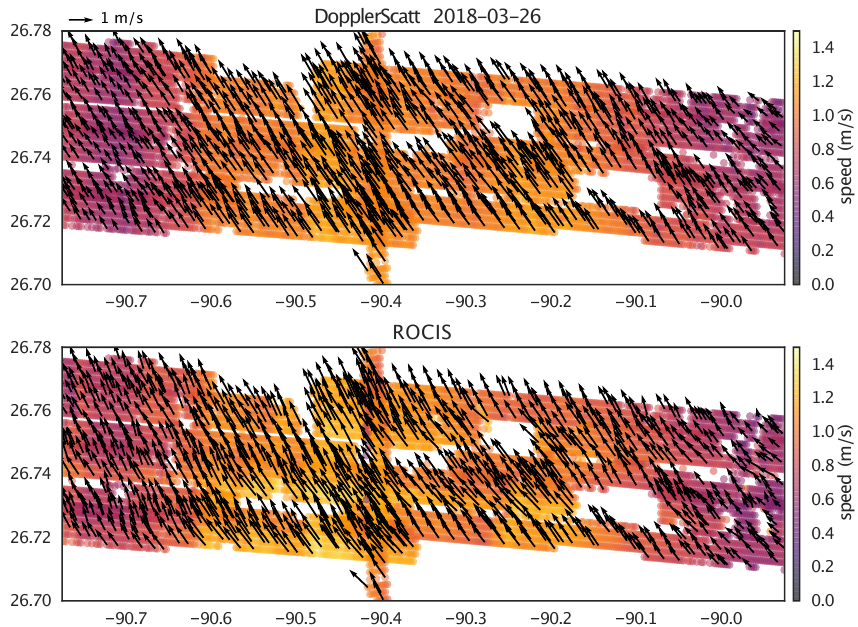
Figure 19. ( upper ) DopplerScatt surface current speed (color) and direction interpolated to ROCIS locations; ( lower ) ROCIS data. Data collected on 26 March 2018.